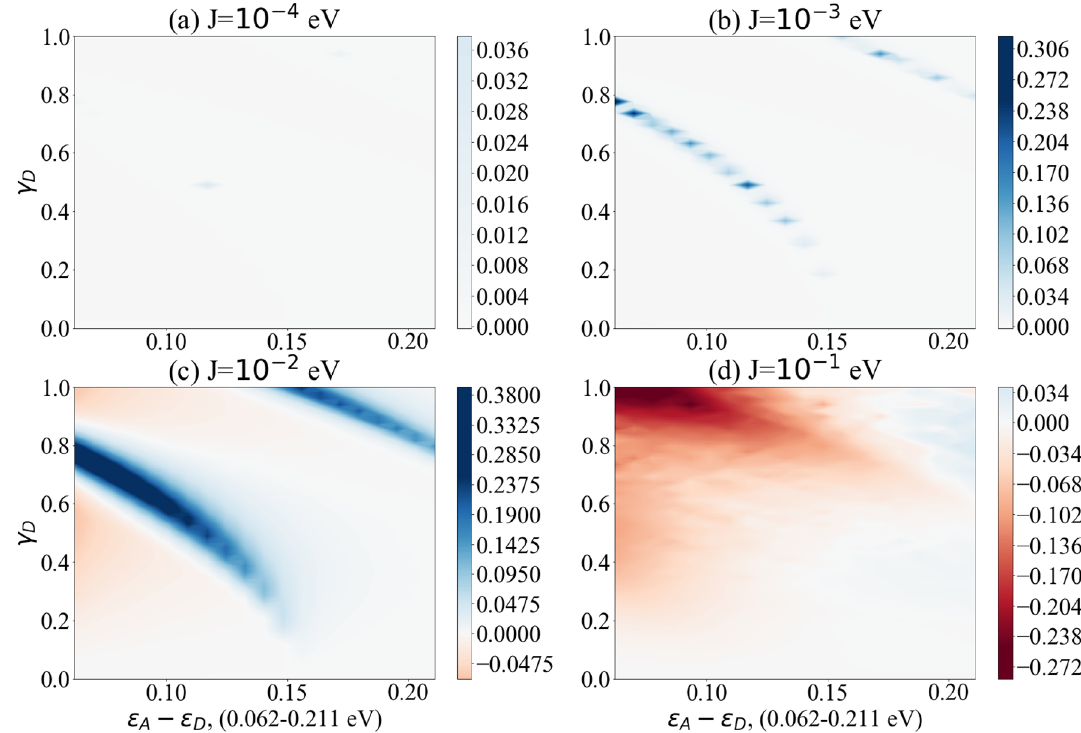
Figure 5. The difference between the maximum probability of transition with and without vibronic mode (cid:31) P Max as a function of the dimer detuning (ε A − ε D ) and the coupling strength between donor and vibronic mode (γ D ) . Results show coupling to vibronic mode frequency ω = 0.1537 eV ( 1240 cm − 1 ). Bluer regions